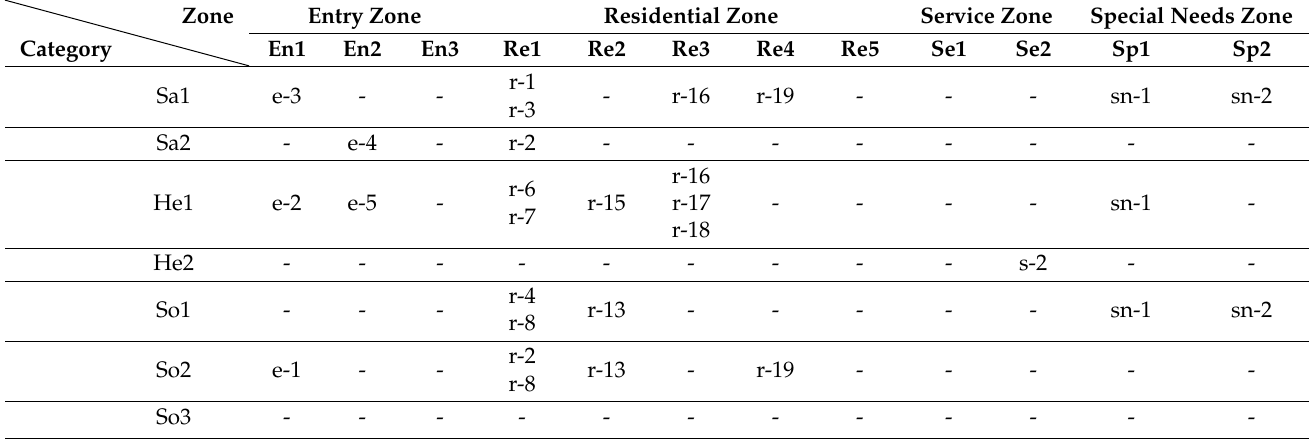
Table 9. Analysis